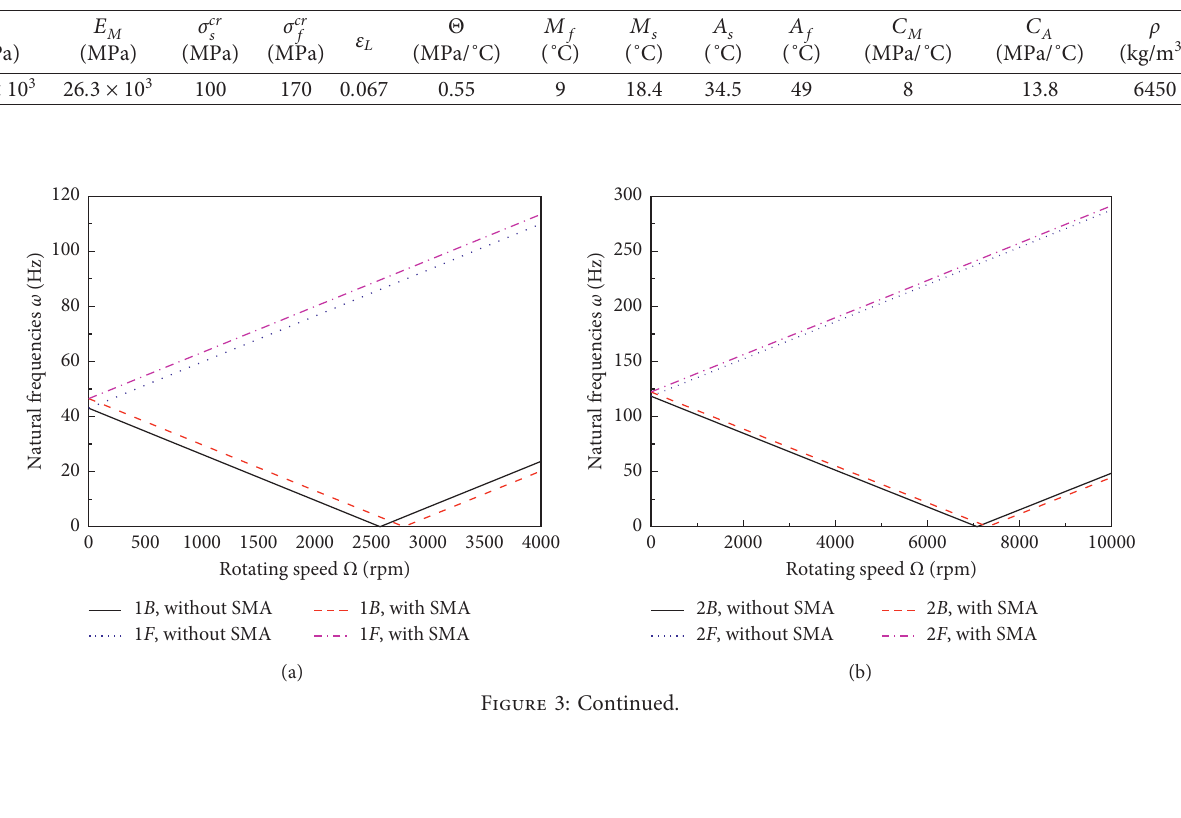
Table 2: Material properties of SMA [23].